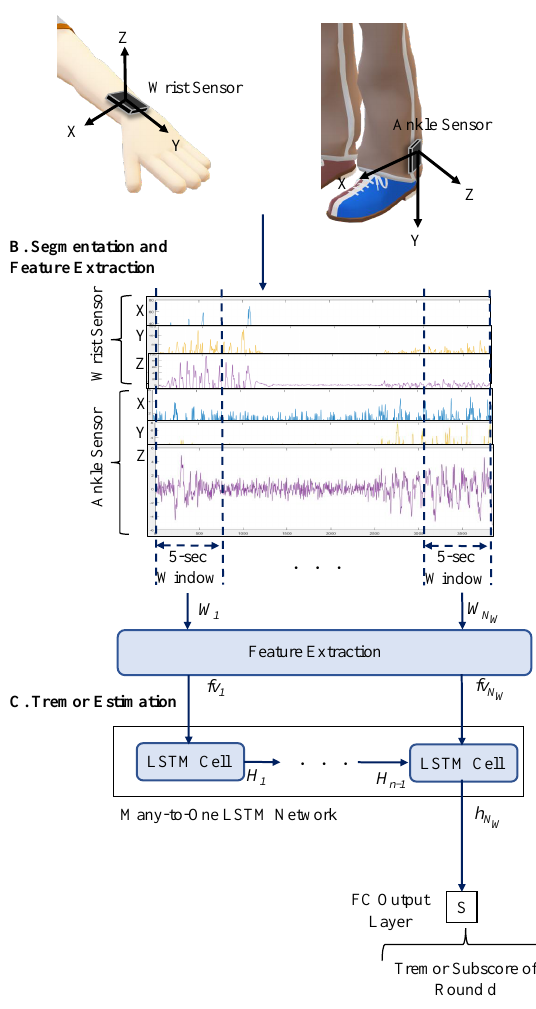
Figure 1. ( A ) Placement of the wearable sensors on wrist and ankle; ( B ) A total of 78 features are extracted from every 5-s segment of the data; ( C ) Estimation of the Parkinsonian tremor subscore ( d ) based on the LSTM method. N is the number of 5-s windows in round d and H represents the W hidden